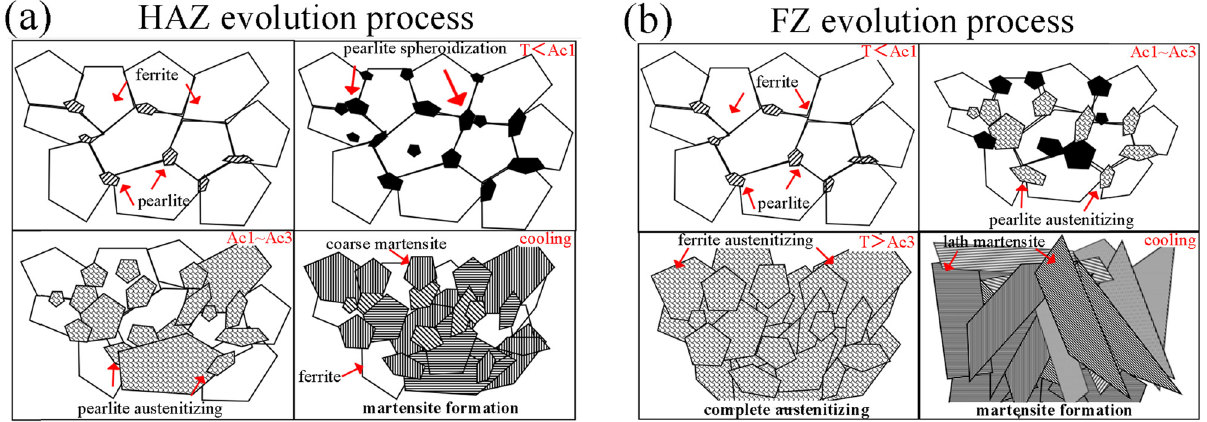
Figure 16: Schematic of the nugget evolution: ( a ) HAZ evolution process, ( b ) FZ evolution